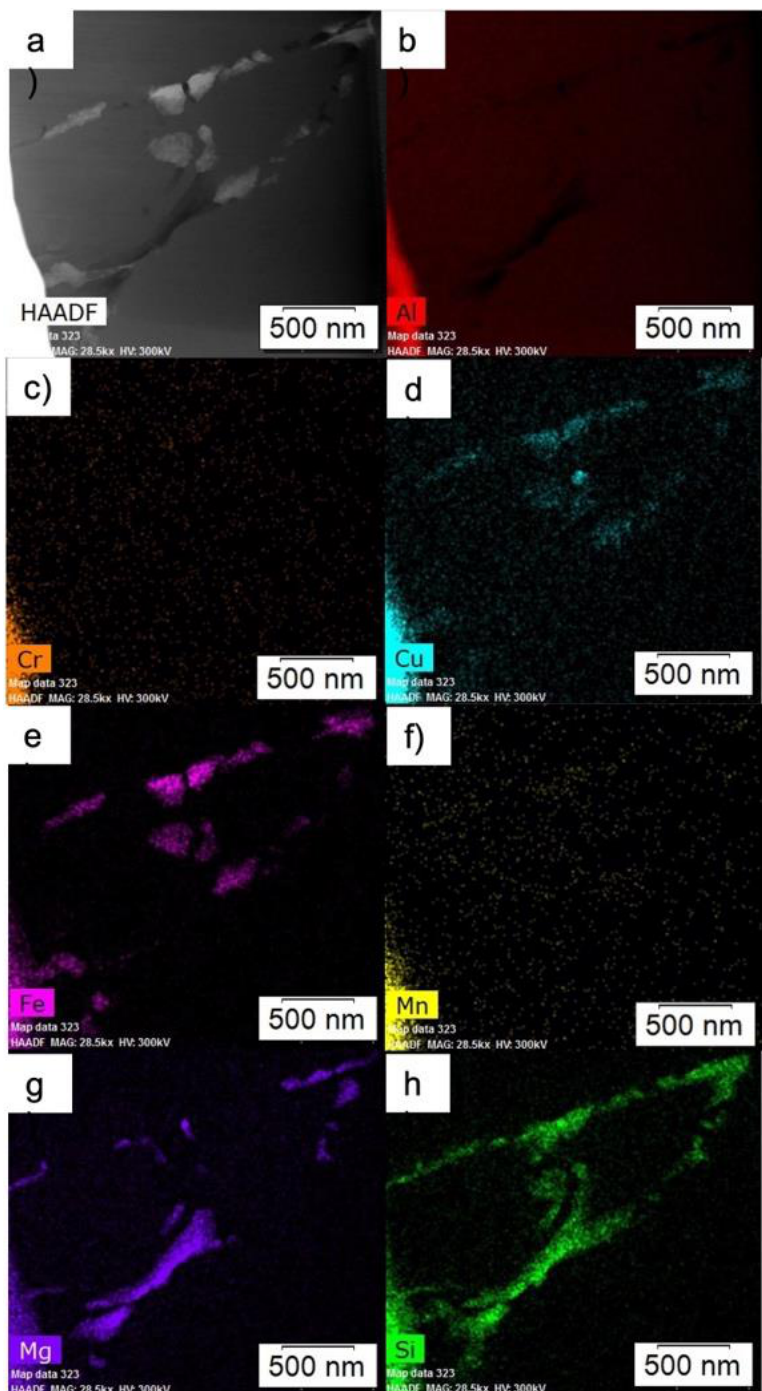
Figure 4. High magnification ( a ) HAADF, and EDS maps of ( b ) Al, ( c ) Cr, ( d ) Cu, ( e ) Fe, ( f ) Mn, ( g ) Mg, and ( h ) Si of a boundary in the as-atomized powder.